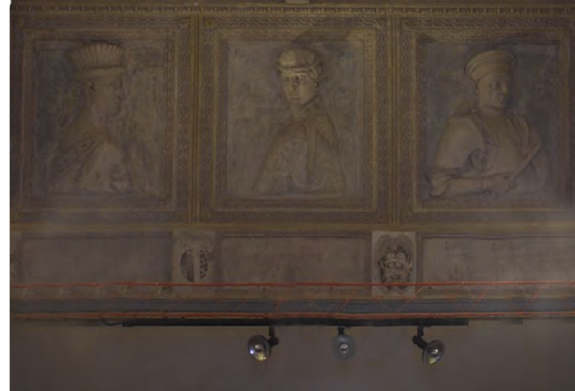
Figure 10. Details of the room and ceiling coming from Photoscan